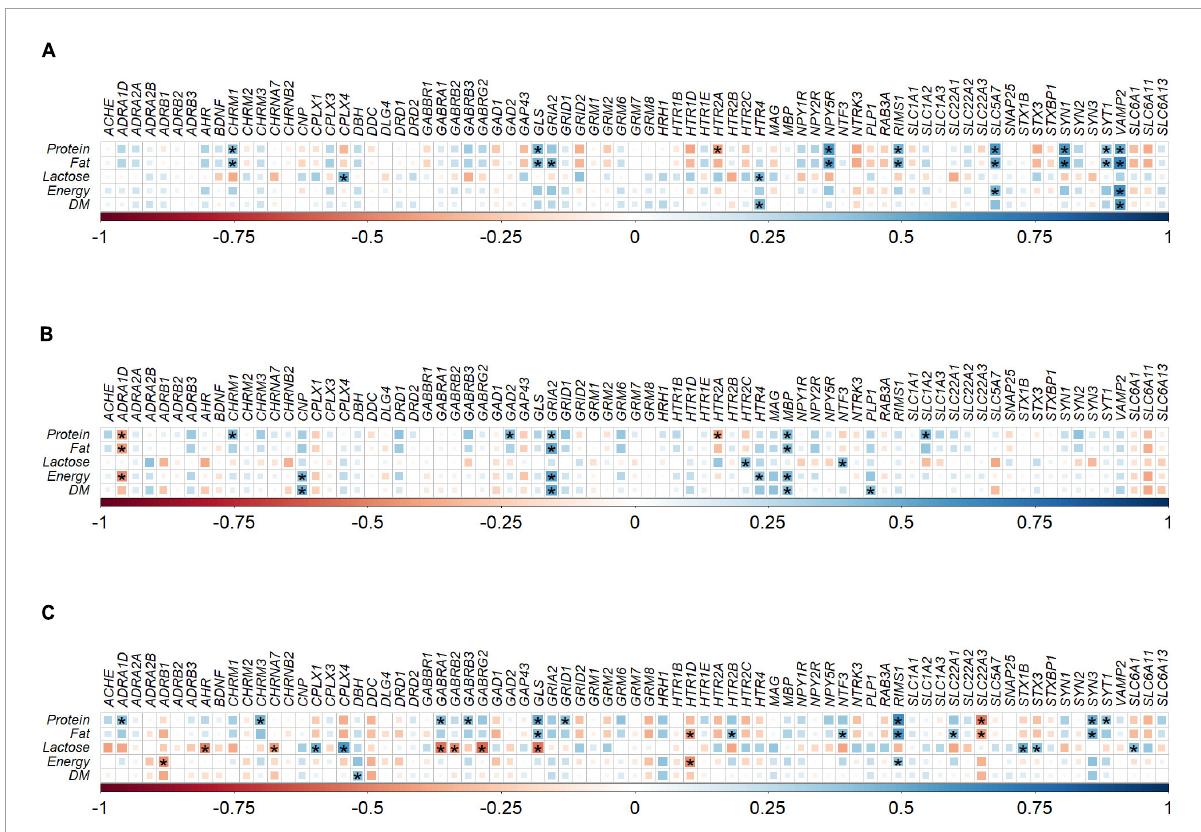
FIGURE3 Correlation plot depiction of the Spearman correlations between milk nutrient intake and gene expression levels in (A) hippocampus ( n = 22), (B) prefrontal cortex ( n = 23), and (C) striatum ( n = 23) tissue samples obtained from pigs fed with milk from bovine, ovine or caprine species. The color and size of the squares indicate the magnitude of the correlation, i.e., blue indicates positive correlation and red indicates negative correlation. Asterisks indicate the significance of correlation ( P < 0.05). The legend at the bottom of each correlation plot shows the correlation coefficients with their corresponding colors. DM, dry matter; n , number of samples used for